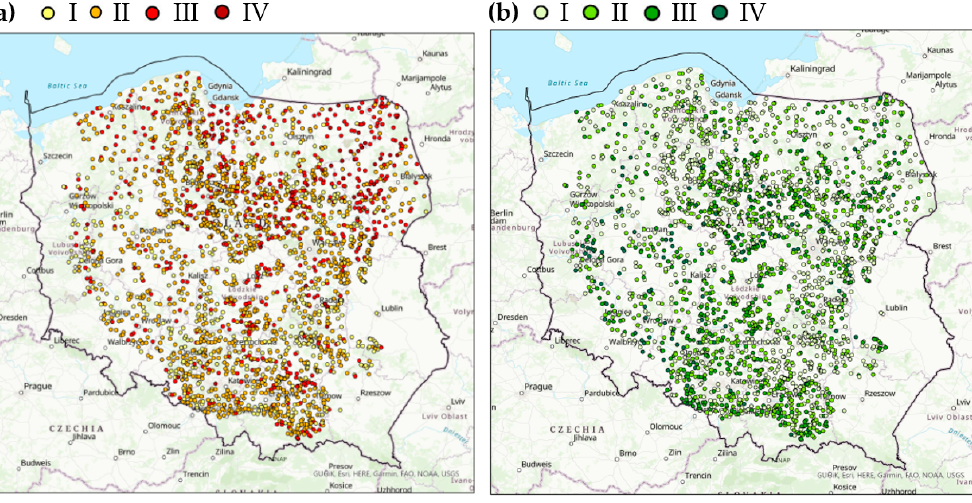
Figure 2. The soil characteristic distribution among the sites ( a ) organic carbon: I—<1% C (very low), II—1–2% C (low), III—3–6% C (medium), IV—>6% C (high), ( b ) mineral nitrogen: I—<10 mg kg − 1 , II—10.01–20.0 mg kg − 1 III—20.01–40.0 mg kg − 1 , I—–>40.0 mg kg − 1 , ( c ) fractions smaller than 0.02 mm: I—<10%, II—10–20%, III—20–35%, IV—>35%, ( d ) soil pH: I—alkaline soils, pH > 7.2, II—neutral soils, pH = 6.6–7.2, III—slightly acidic soils, pH = 5.6–6.5, IV—acidic soils, pH = 4.6–5.5, V–highly acidic soils, pH< 4.5.